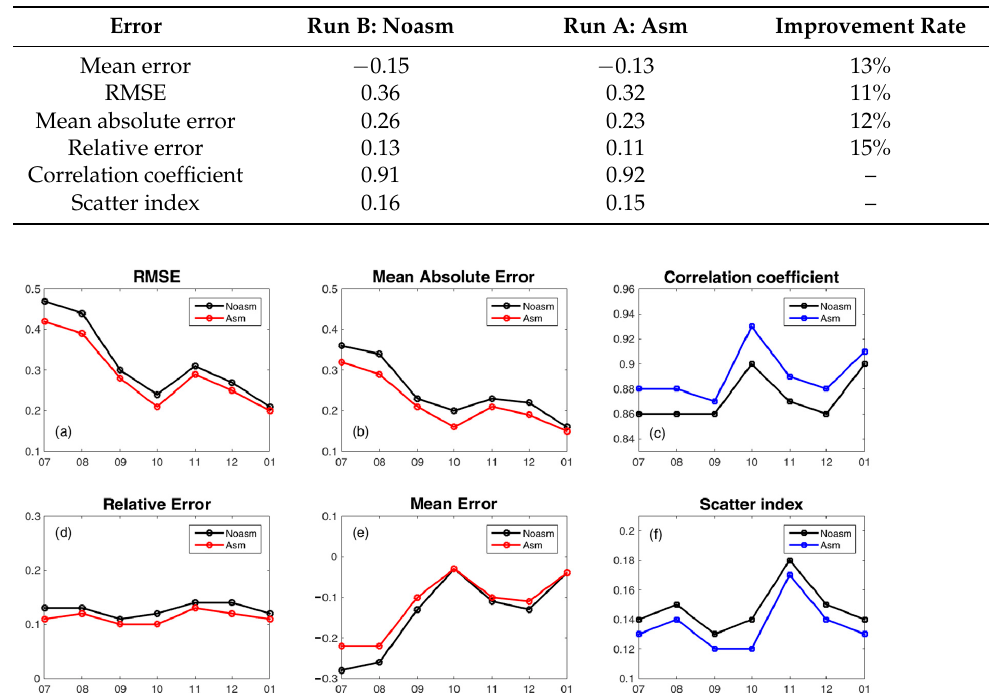
Table 1. Statistical analysis of significant wave heights from runs with and without assimilation at orbit tracks of CFOSAT. The period of analysis is from 1 July 2020 to 31 January 2021.